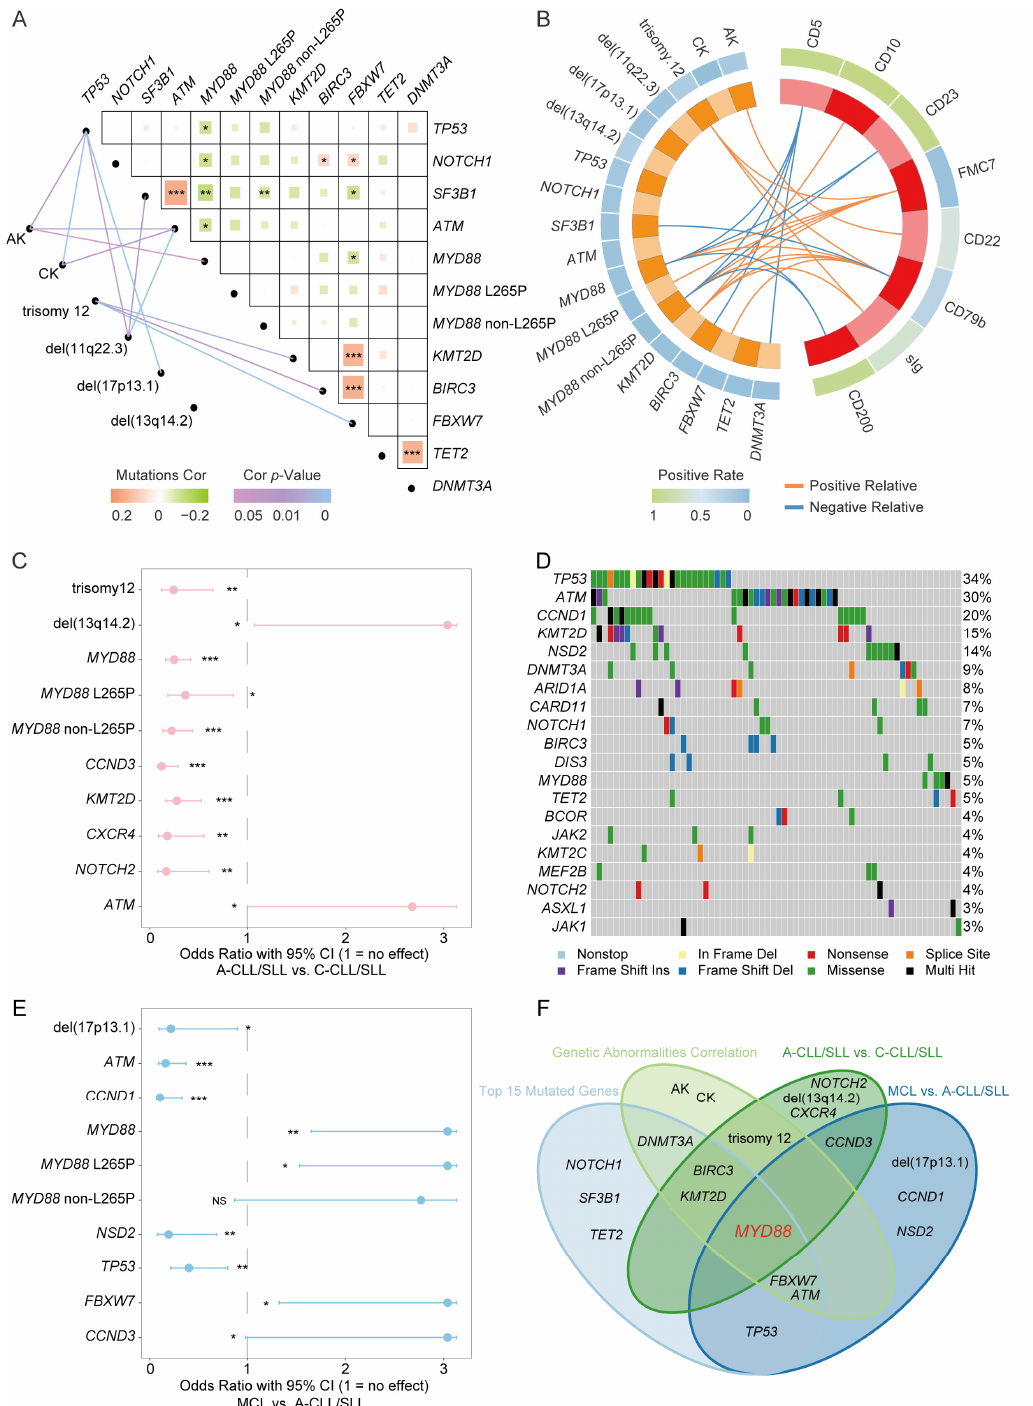
Figure 2. Correlation analysis between genetic abnormalities and immunophenotypes in CLL/SLL. ( A ) Gene variant somatic interaction and correlation with cytogenetic aberrations. ( B ) Genetic ab- normalities associated with CD markers. ( C ) Genetic abnormality differences between atypical CLL/SLL and classic CLL/SLL. ( D ) Mutation landscape in 74 newly diagnosed MCL patients. ( E ) Gene variant di ff erences between MCL and atypical CLL/SLL. ( F ) Genetic abnormality overlapping between the mentioned grouping analysis. A-CLL/SLL: atypical immunophenotype CLL/SLL; C- CLL/SLL: classic immunophenotype CLL/SLL; ***: p value < 0.001; **: p value < 0.01; *: p value < 0.05; NS: no signi fi cance.